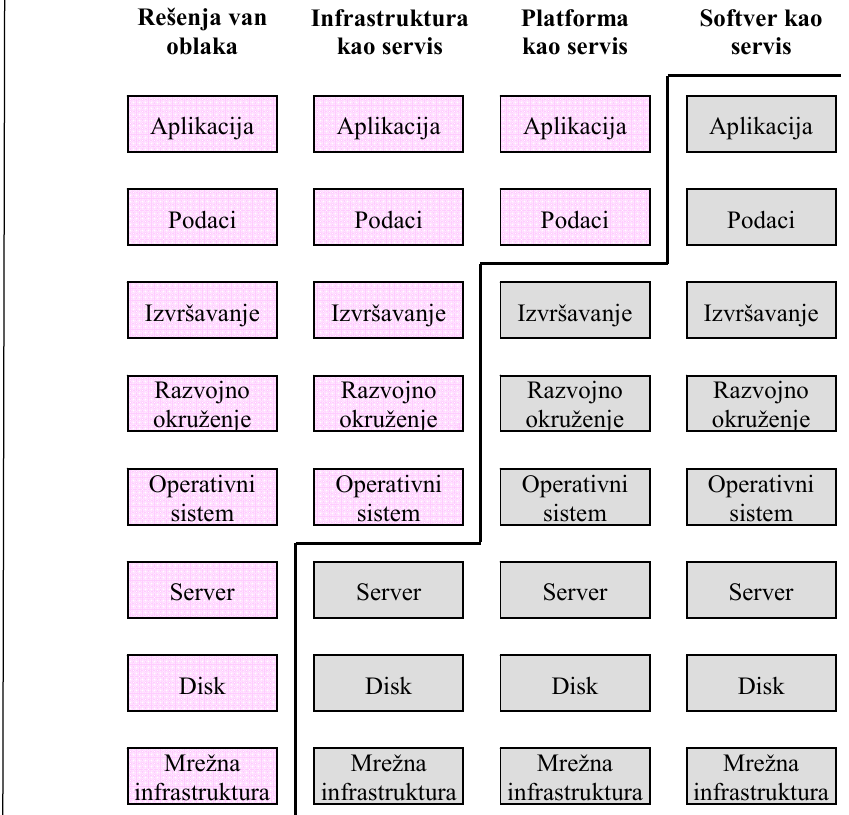
Figure 2 – Competences of providers and users for different services in the